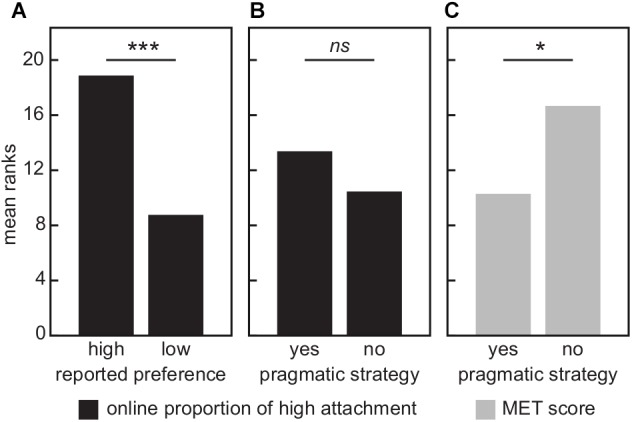
Group comparisons. (A) Online proportion of high attachments significantly differed between participants with offline reported high- and low-attachment preferences. (B) Use of a pragmatic strategy (yes/no) did not influencethe overall online proportion of high attachments. (C)
Post hoc observation that participants who resorted to pragmatic strategy had lower musical ability (MET score; Wallentin et al., 2010). All scores were converted to mean ranks for Mann–Whitney U tests. ∗p < 0.05 and ∗∗∗p < 0.001.